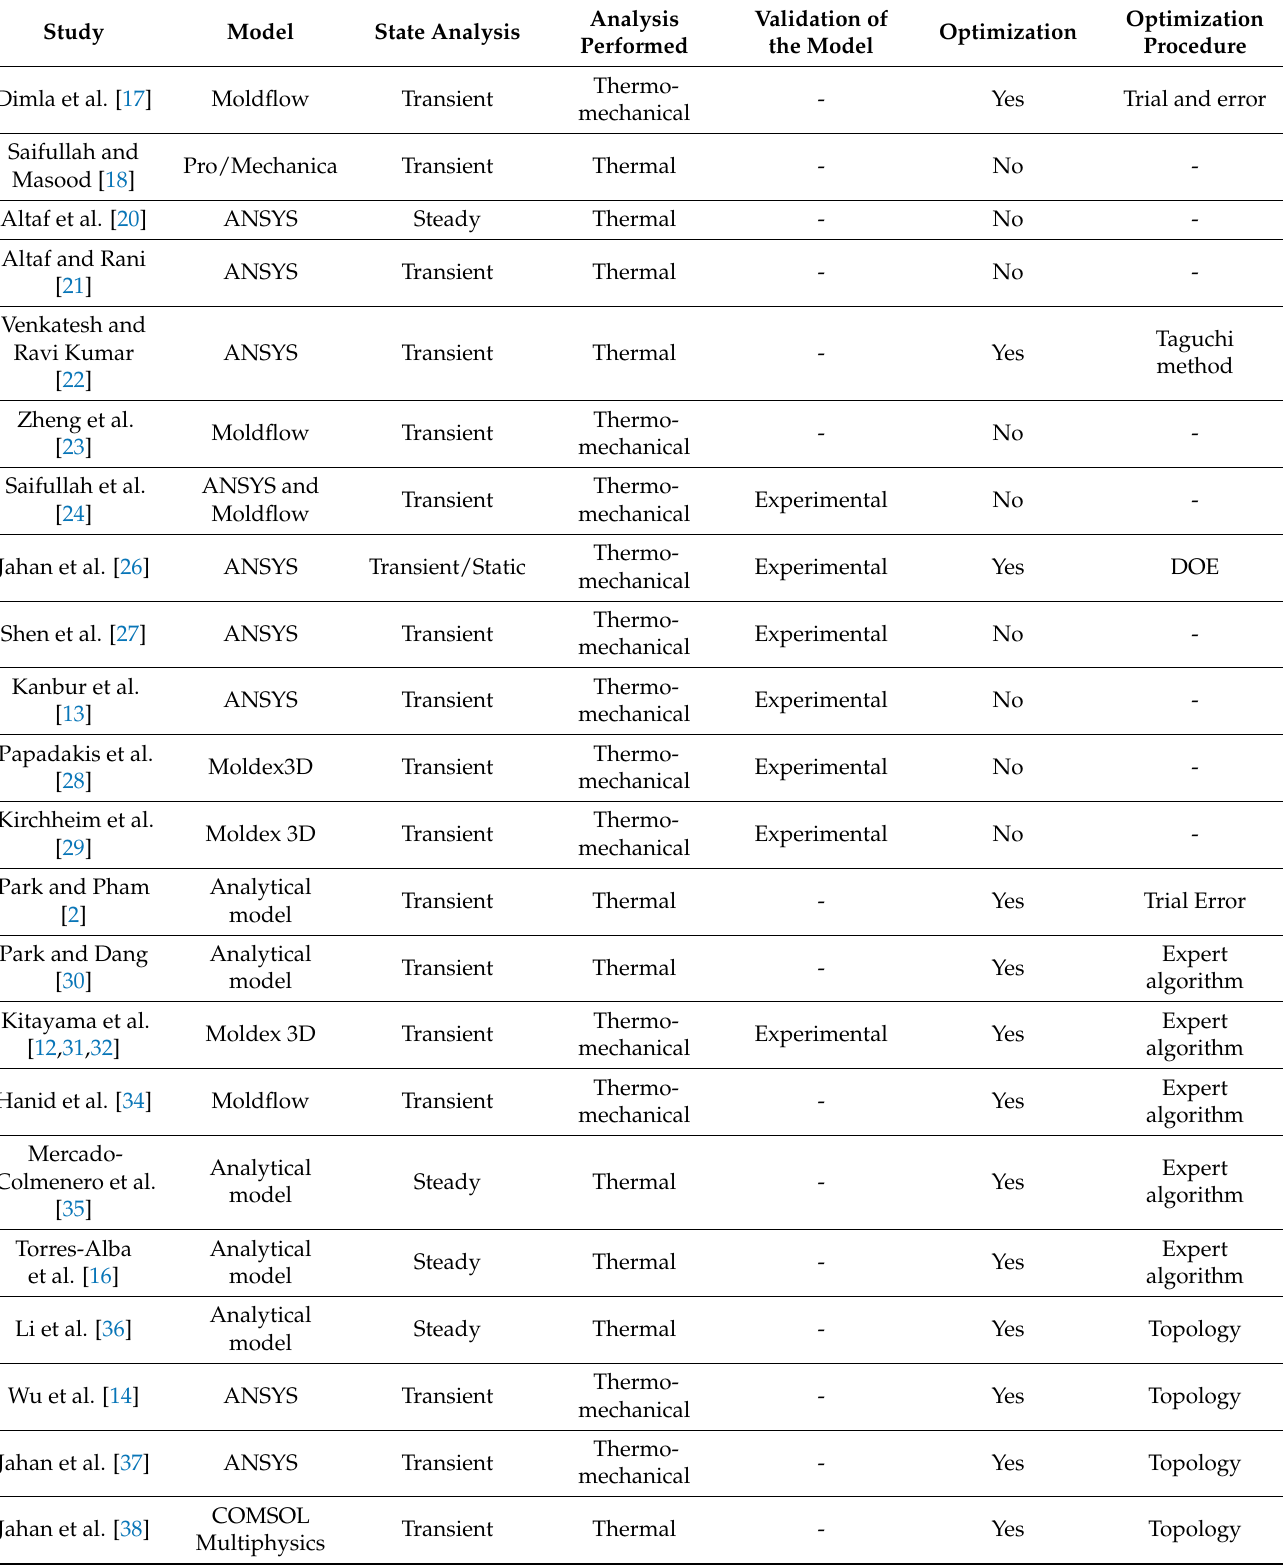
Table 1. Summary of thermo-mechanical models